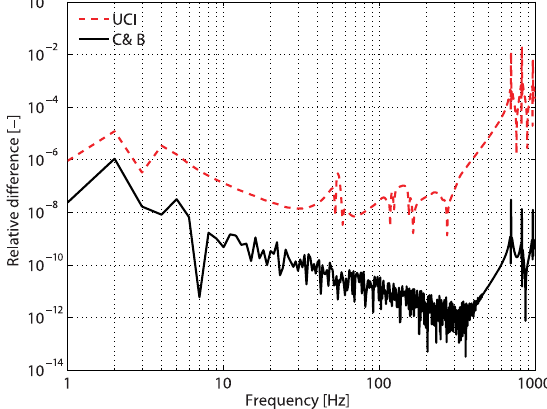
Fig. 6. Relative difference between the direct solution and the C&B method (solid line) and the UCI approach (dashed line), both cases using all inner modes.